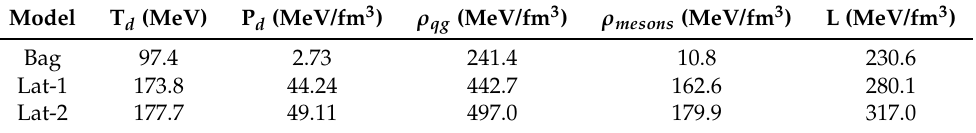
Table 1. Physical parameters of the QCD transition derived from the considered equations of state.